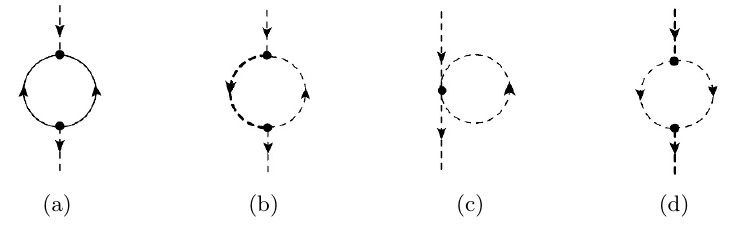
Figure 5 . One-loop corrections for the h (cid:30)(cid:30) (cid:3) i propagator in the n = 3